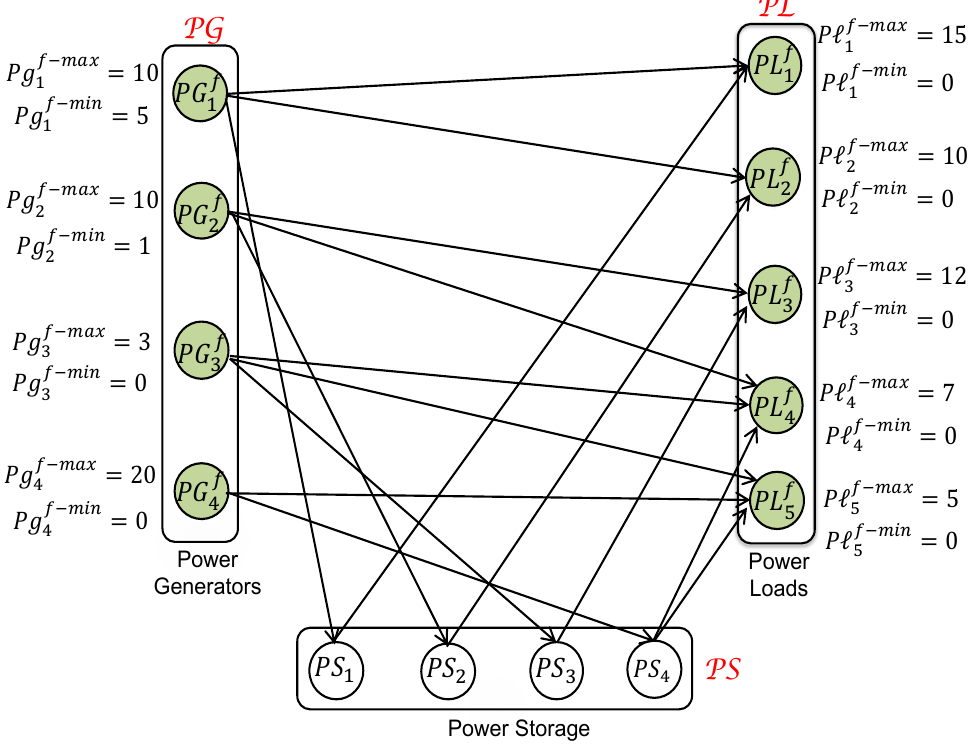
Figure 17. Demonstration scenario considered for power bounds and minimum Ess